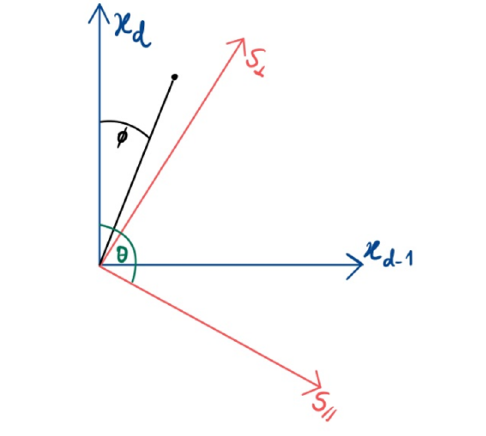
Figure 3 . The two sets of orthogonal coordinates in the wedge